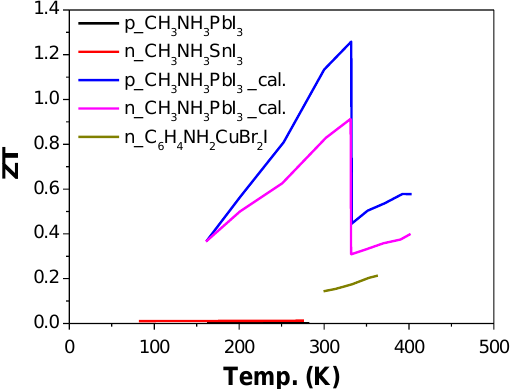
Figure 12. ZT value of hybrid perovskite materials. The majority carrier types (n or p) were marked in the legend. The symbol “cal.” means the results come from the calculation.